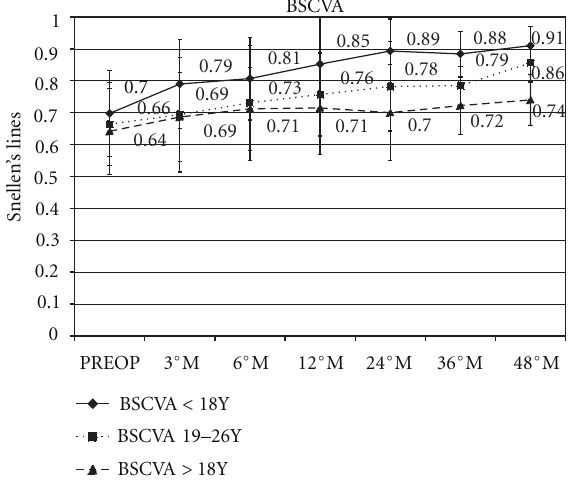
≥ 27 years) varied by a mean of − 0.4 D ( P = 0 .